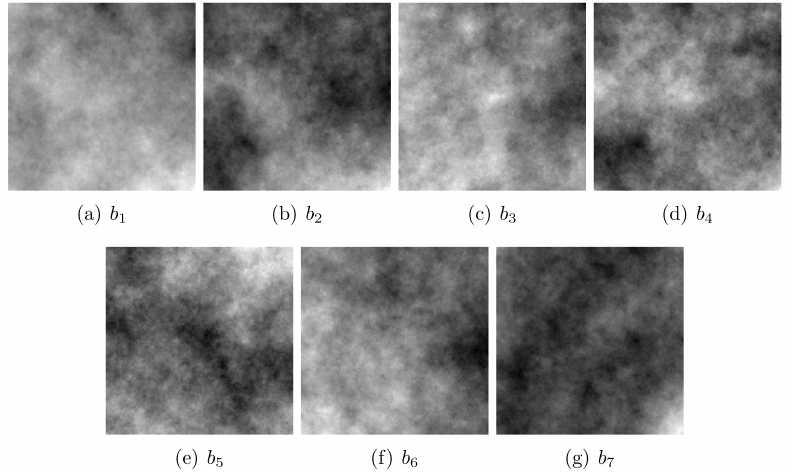
Figure 1. The seven spectral bands of the MSI with low generated complexity ( H = 0.9).